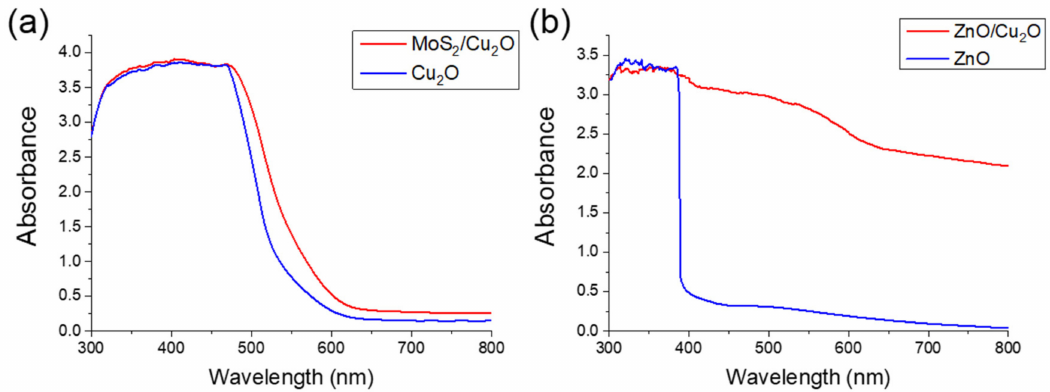
Figure 4. Ultraviolet–visible light spectrum analysis diagram of ( a ) MoS 2 /Cu 2 O and ( b ) ZnO/Cu 2